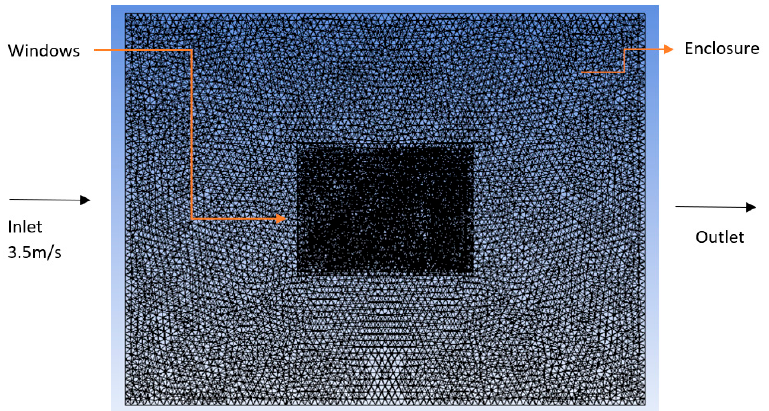
Figure 3. Mesh representation. Figure 3. Mesh Table 7. Meshing nodes and elements.